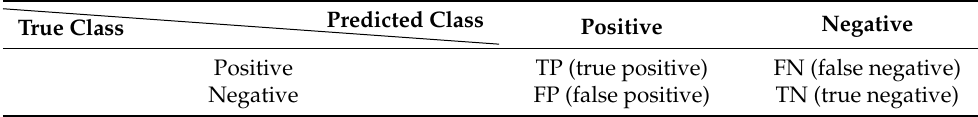
Table 4. Confusion matrix for binary classification